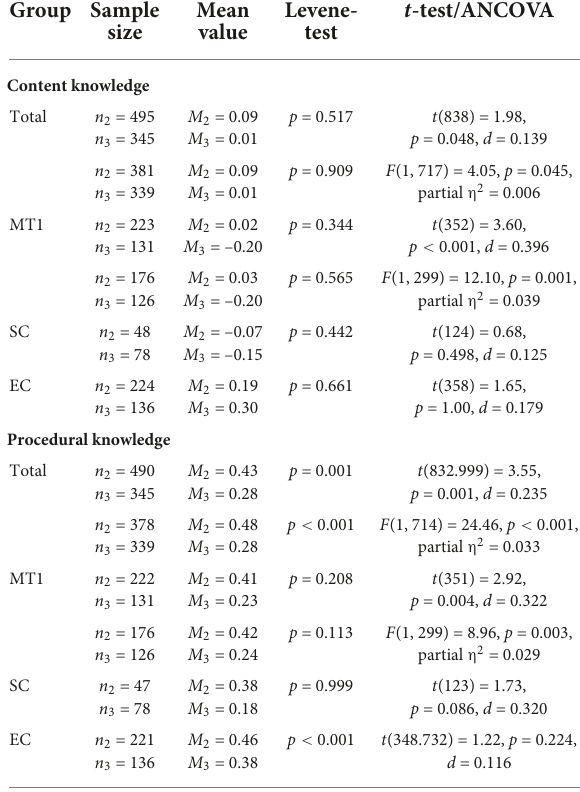
TABLE 3 Comparison of person parameters (measurement points 2 and 3) t -test for independent samples and ANCOVA. Group Sample